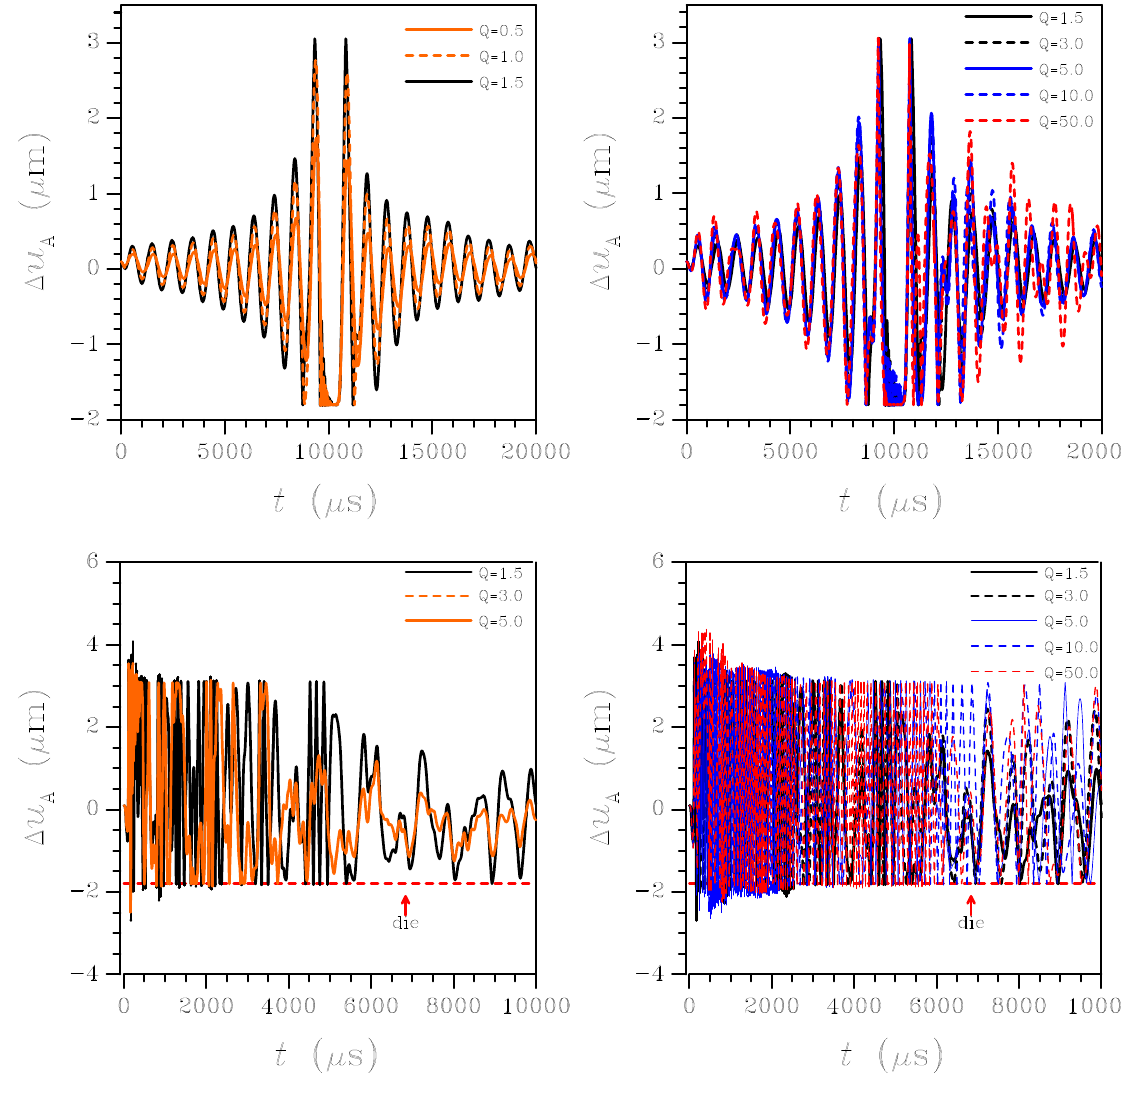
Figure 10. Reduced order modelling: effect of damping on the (top) low- g and (bottom) high- g MEMS responses, in terms of relative displacement ∆ u